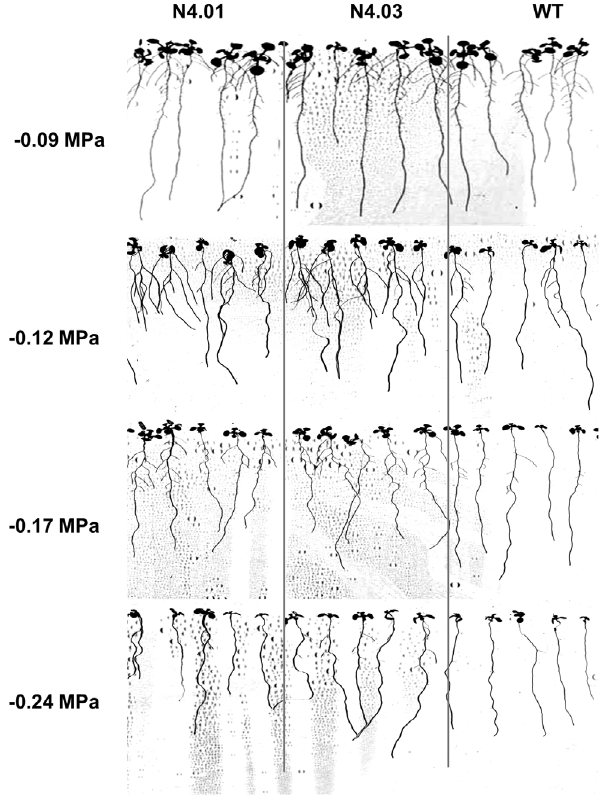
Figure 5. Representative root growth of transgenic Arabidopsis plants overexpressing GmNAC004 in response to water deficit conditions. Two T4 homozygous transgenic Arabidopsis (N-4.01 and N-4.03) and WT plants were grown on nutrient agar plates diffused with different concentrations of PEG. The plants were 12 days old (8 days after stress exposure).